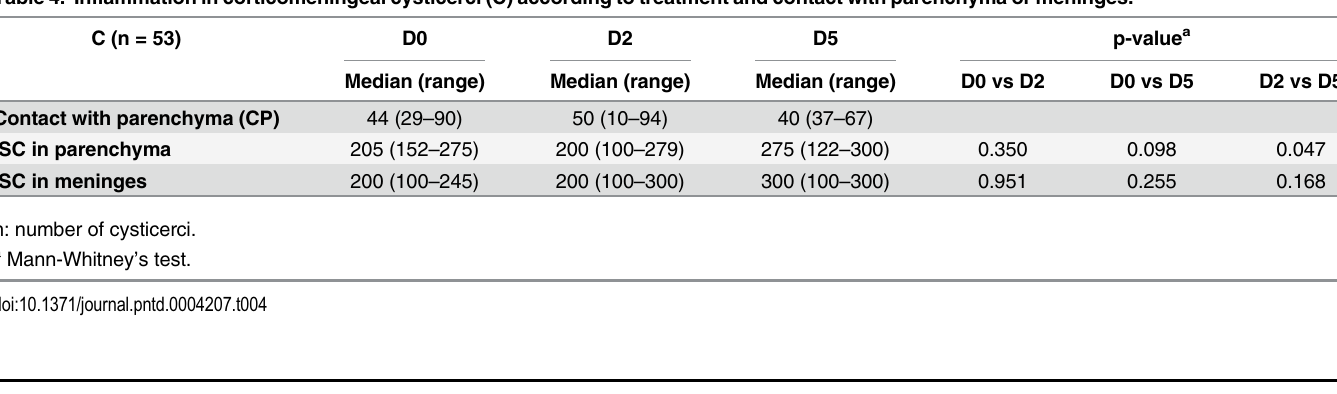
Table 4. Inflammation in corticomeningeal cysticerci (C) according to treatment and contact with parenchyma or meninges. C (n = 53)